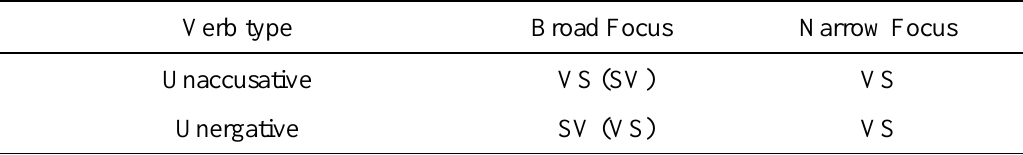
Table 1. Expected word order of verb-type across focus-types in Italian Verb